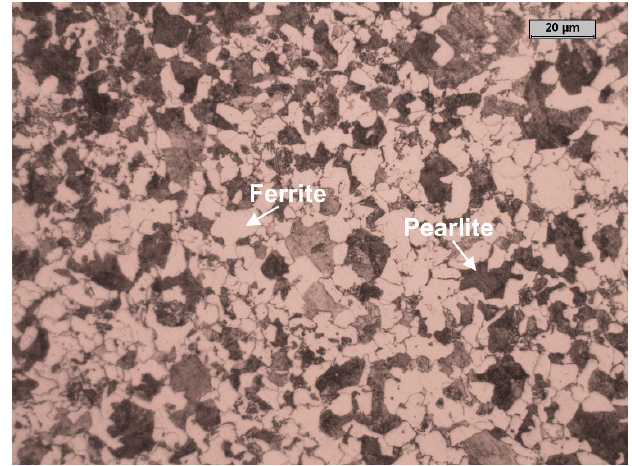
Figure 1. Optical micrographs of the N80 carbon steel microstructures.